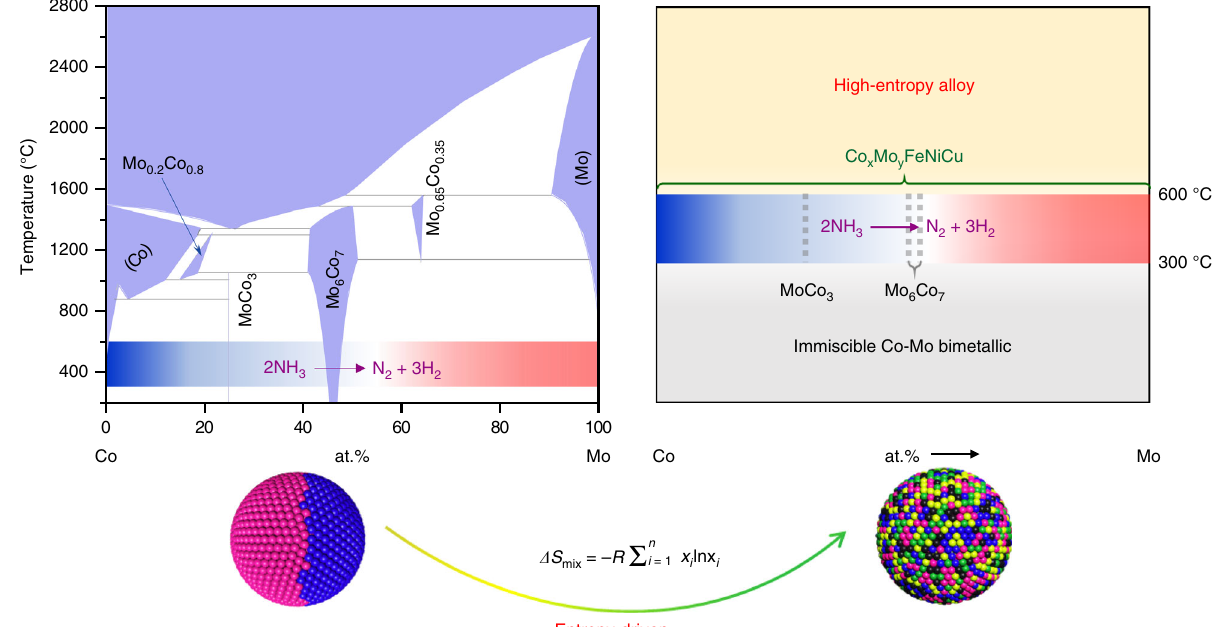
Fig. 1 HEA catalysts breaking the miscibility limitation of conventional binary alloys. The phase diagram of bimetallic Co-Mo (left) is reprinted from Wang et al. 51 , with permission from